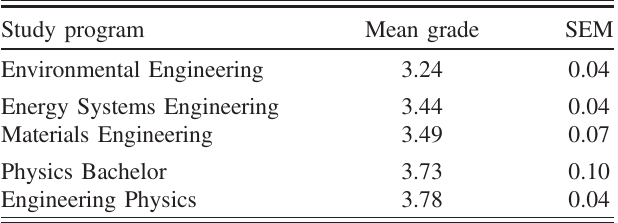
TABLE III. Mean course grades on the electromagnetism course for the five largest study programs.